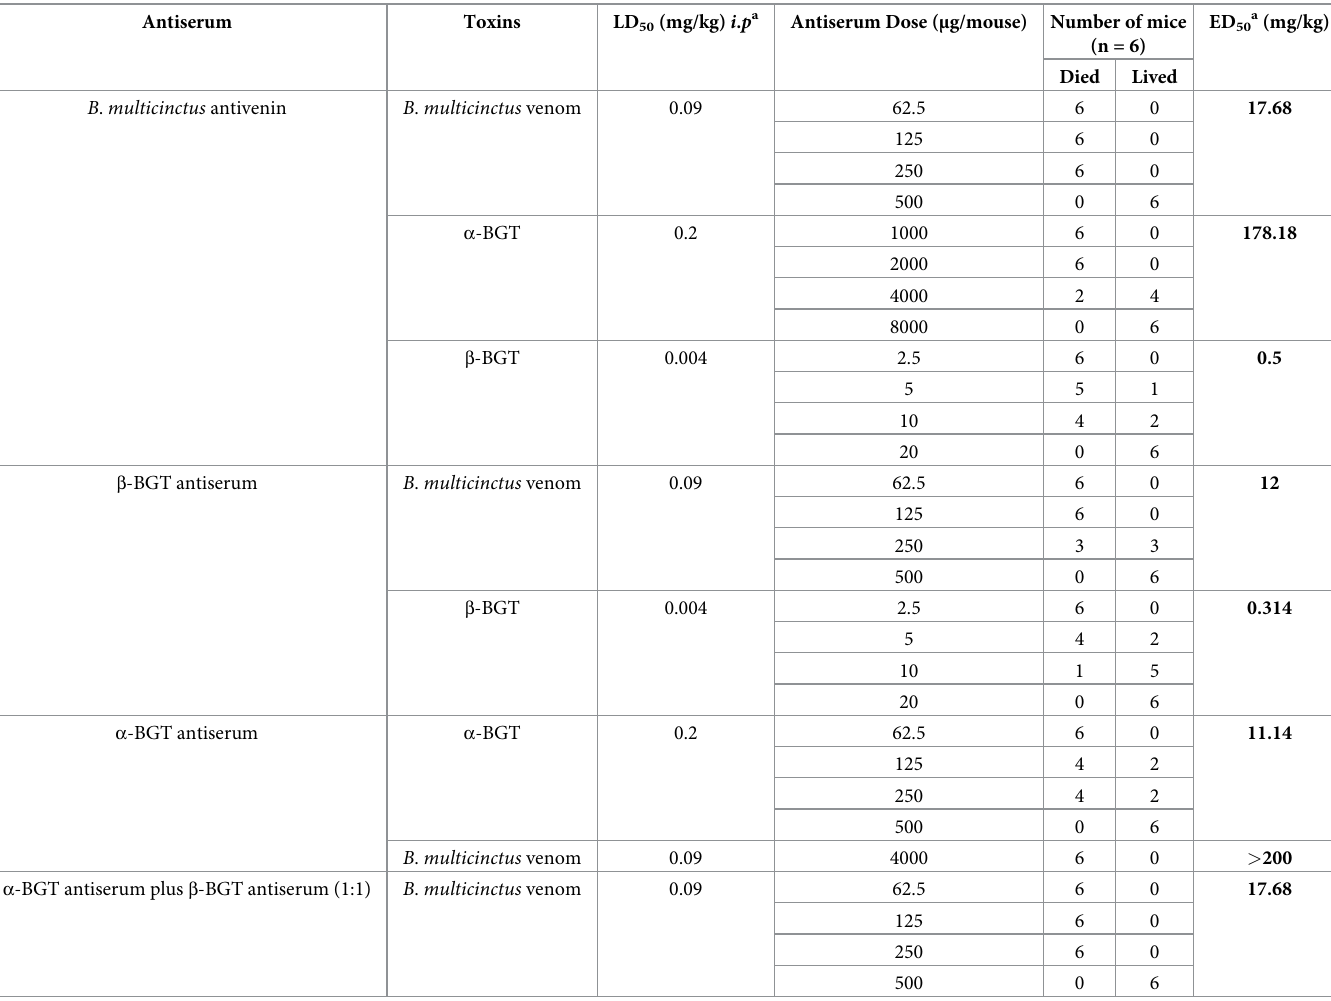
Table 2. ED 50 determination of B . multicinctus antivenin and the prepared bungarotoxin antiserum against B . multicinctus venom and purified